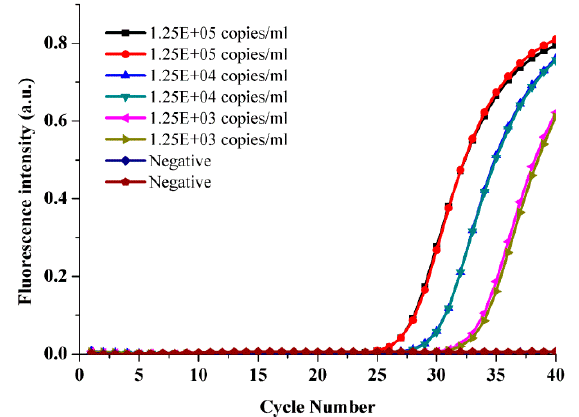
Figure 3. DNA was extracted on the integrated chip from different concentrations of the positive quality control HPV58 by real-time PCR.